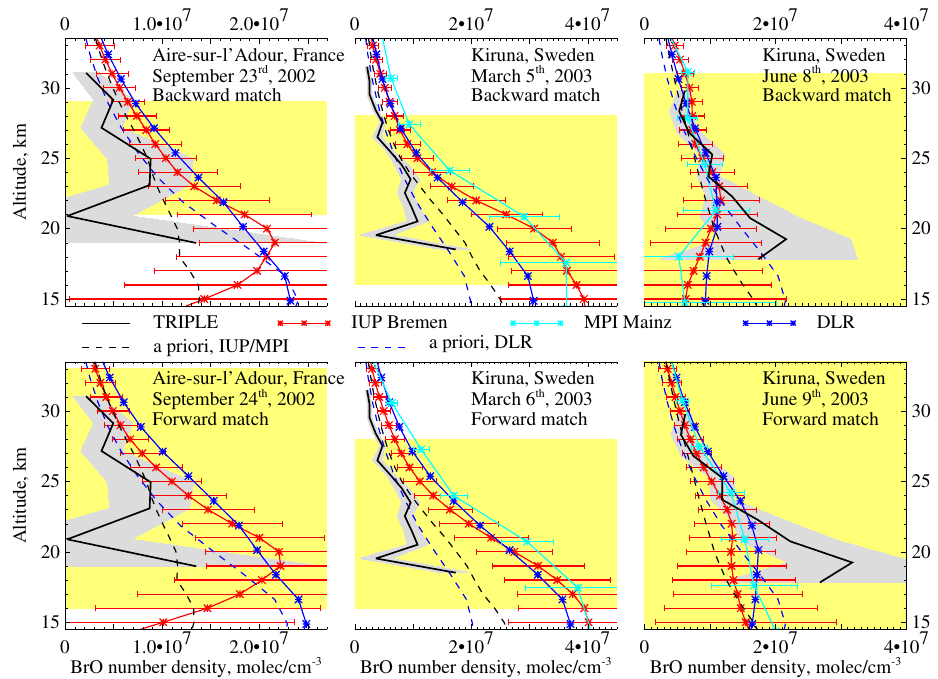
Fig. 29. Comparison of BrO vertical distributions retrieved from SCIAMACHY limb measurements using different retrieval algorithms to coinciding balloon-borne TRIPLE observations. Left panels: balloon launch in Aire-sur-l’Adour (mid-latitude) on 24 September 2002. Middle panels: balloon launch in Kiruna (high latitude) on 6 March 2003. Right panels: balloon launch in Kiruna on 9 June 2003. Gray shadings depict the statistical error of the TRIPLE results (1- σ ). The absolute error is on the order of 35% (see text). Yellow areas mark vertical ranges where according to trajectory model calculations both instruments probe the same air mass.